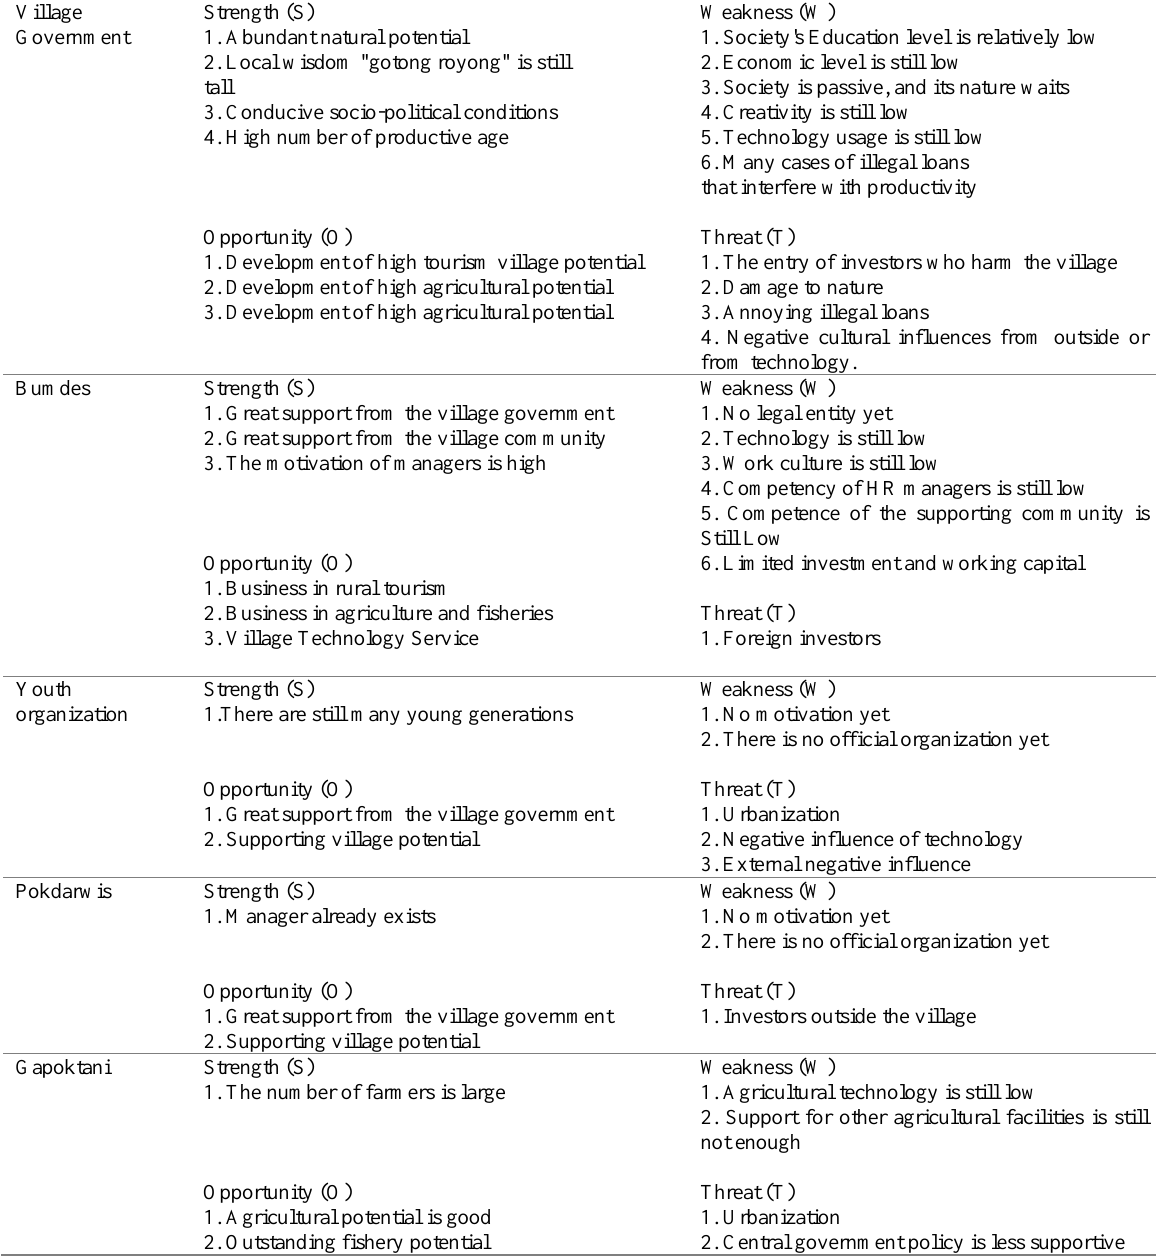
Table 3: Results of Interviews and Open Questionnaires (SWOT